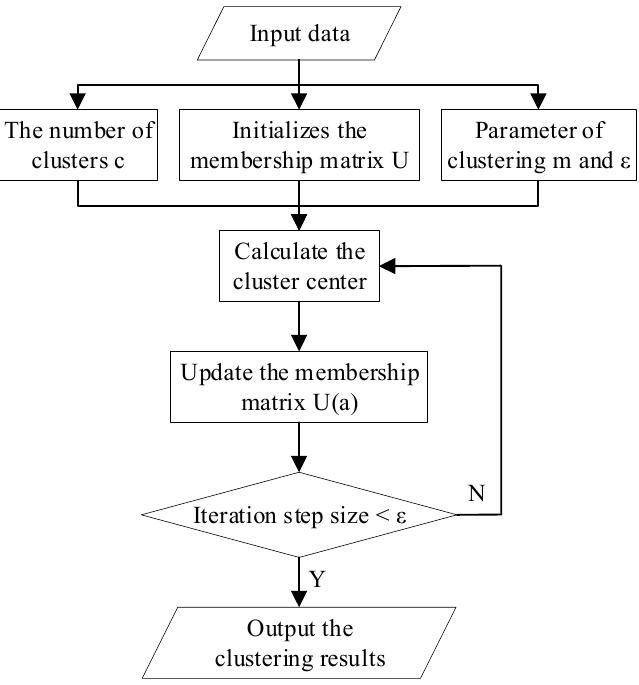
Figure 1. Flow chart of improved FCM clustering algorithm.